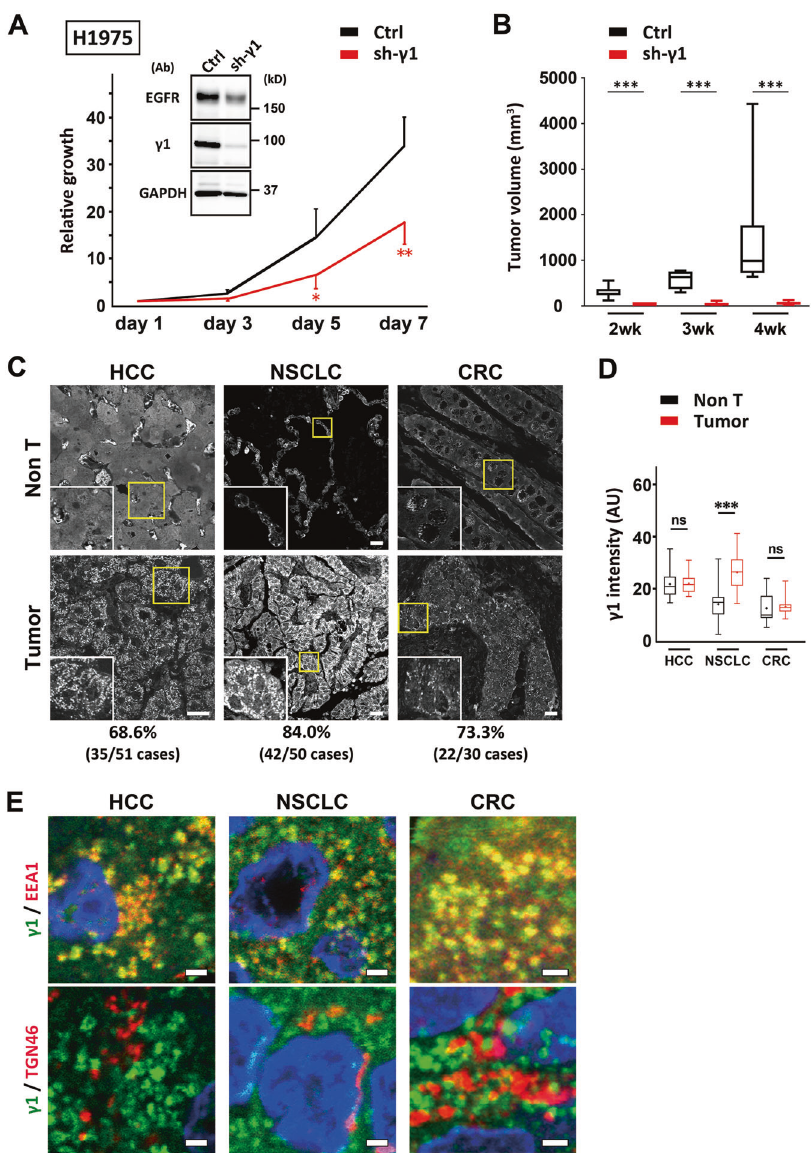
Fig. 8 AP-1 supports cell growth and is expressed at high levels in endosomes of some human cancer tissues. A ARPE-19 and H1975 cells stably expressing sh- γ 1 or vector (Ctrl) were subjected to cell proliferation assays. Depletion of γ 1-adaptin and EGFR was con fi rmed by western blotting using the indicated antibodies (Ab). Data are plotted as the means ±SD of three experiments. Statistical differences between Ctrl and sh- γ 1 at each time point were analyzed using Student ’ s t -test (* P <0.05 and ** P < 0.01). B Tumor volumes in xenograft experiments were measured at the indicated time points and displayed as box-and-whisker plots. The horizontal line inside each box represents the median value. The lowest point and highest point are the minimum and maximum of the data set, respectively. Statistical analyses were performed using Mann – Whitney U -test (*** P <0.001). Images of tumors are shown in Supplementary Fig. S7C. C Immunostaining of tissue arrays with paraf fi n tumor sections (Tumor) and adjacent non-tumor regions (Non T) from HCC (grade 1), NSCLC (grade 1), and CRC (grade 2), and using anti- γ 1-adaptin Ab. Boxed regions are magni fi ed and shown in insets. Bars, 20 μ m. The percentage of cases with more intense granular signal for AP-1 in tumors than those in non-tumor regions are indicated at the bottom with the total number of cases in parentheses. Detailed information is listed in Supplementary Table S2. D γ 1 signal in normal (black) and tumor (red) tissue was quanti fi ed, and displayed as box-and-whisker plots. The horizontal line inside each box and ‘ + ’ represents the median value and mean, respectively. The lowest point and highest point are the minimum and maximum of the data set, respectively. Statistical differences between each normal and tumor tissue were analyzed using Mann – Whitney U -test (*** P <0.001, ns: not signi fi cant). E Double-immunostaining of tissue arrays of HCC (grade 1 – 2), NSCLC (grade 1 – 2), and CRC (grade 2) using combinations of anti- γ 1- adaptin, and anti-EEA1 or anti-TGN46 Ab. See Supplementary Fig. S7E for lower magni fi cation images. Bars, 2 μ